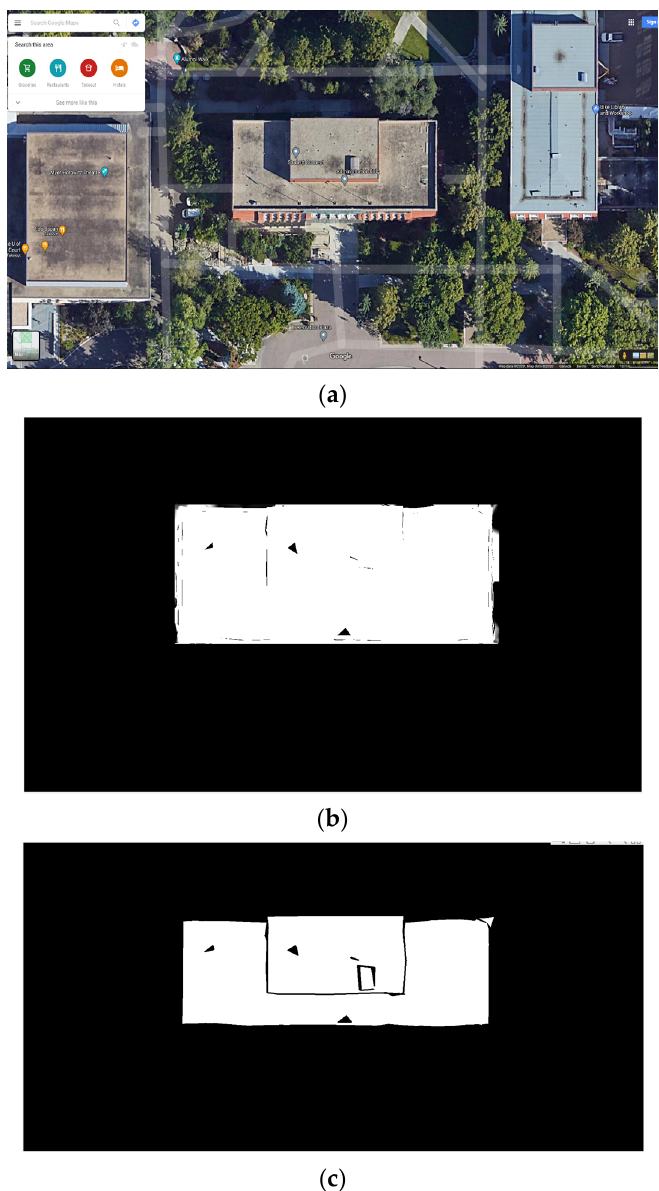
Figure 7. ADMIN building ( a ) satellite image (Imagery ©2021 Google, Imagery ©2021 Maxar Tech- nologies, Map data ©2021), ( b ) binary map before roof identification, and ( c ) binary map after roof